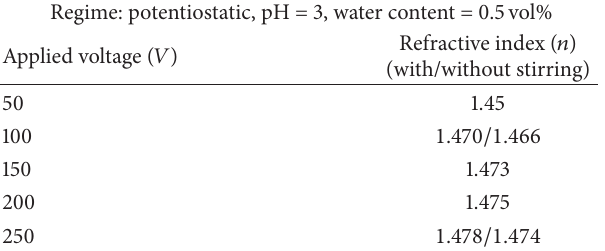
Table 1: Refractive index of the oxide films prepared in potentio- static mode with and without mechanical stirring of the electrolyte solution.